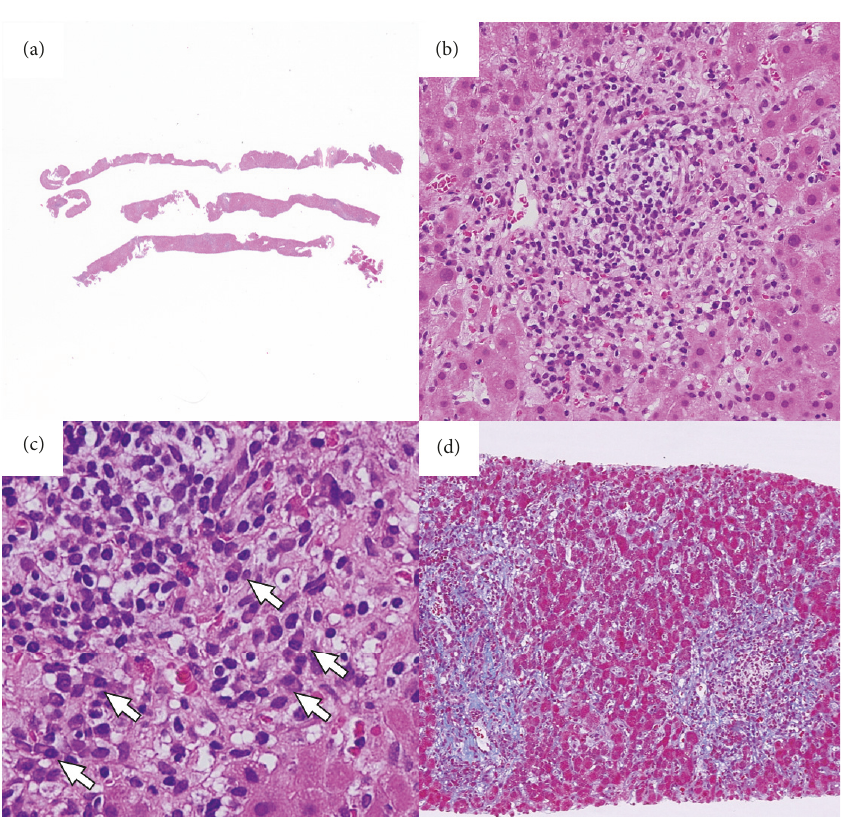
Figure 2: The histological findings of liver biopsy. (a) The specimens of transjugular liver biopsy. (b, c) Interface hepatitis with moderate inflammation and infiltrates of lymphocytes and plasma cells (arrows) in the portal area (b, magnification: × 200. Hematoxylin and eosin staining; c, magnification: × 400; hematoxylin and eosin staining). (d) Moderate fibrosis in the portal area and partial destruction of the hepatic lobules with piecemeal necrosis (magnification: × 40; Masson’s trichrome